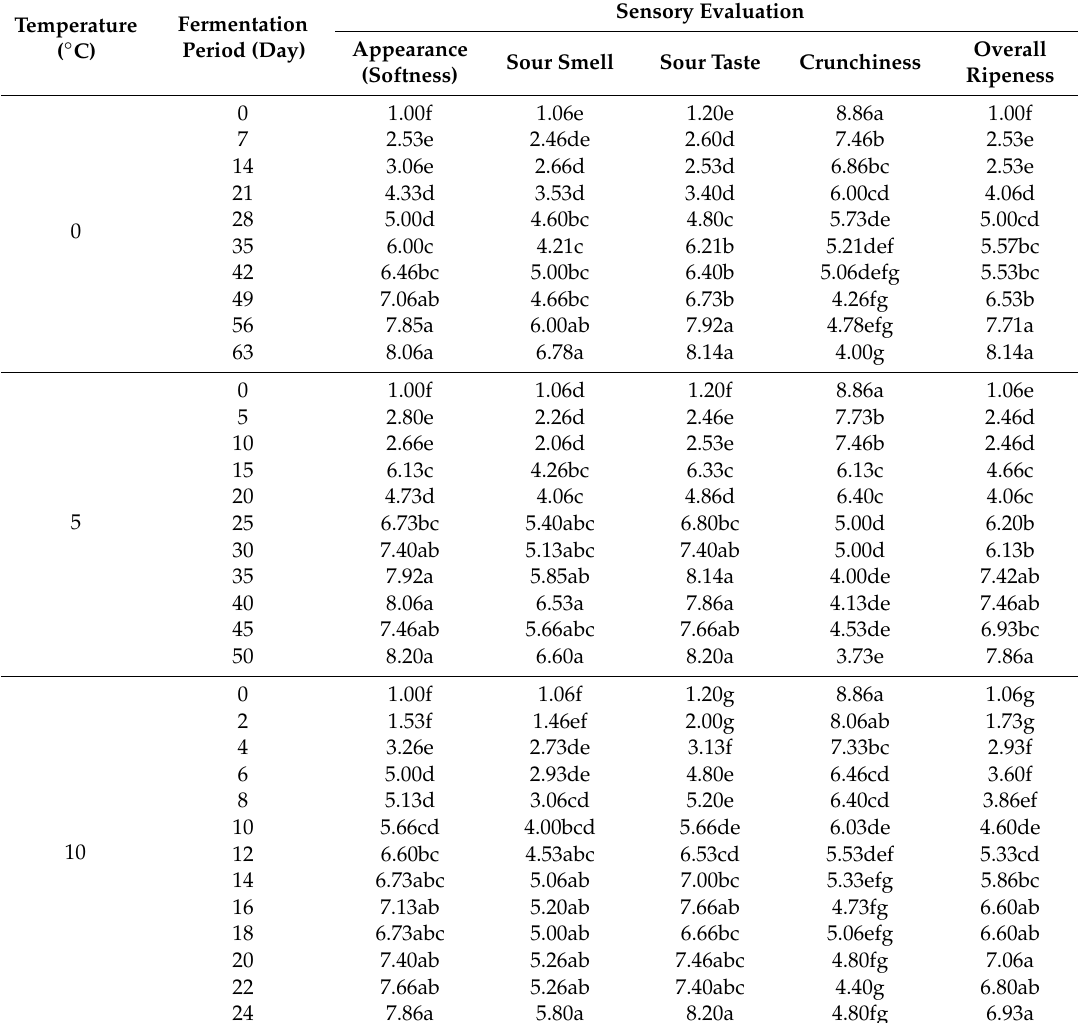
Table 1. Changes in sensory evaluation of Kimchi during fermentation at 0, 5, 10 and 20 ◦ C.